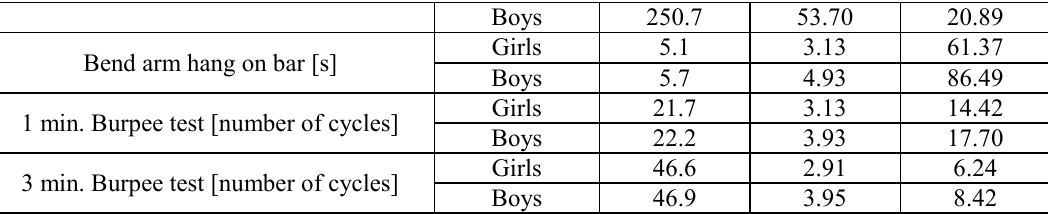
Table key: X - arithmetic mean, s- standard deviation, V- variation